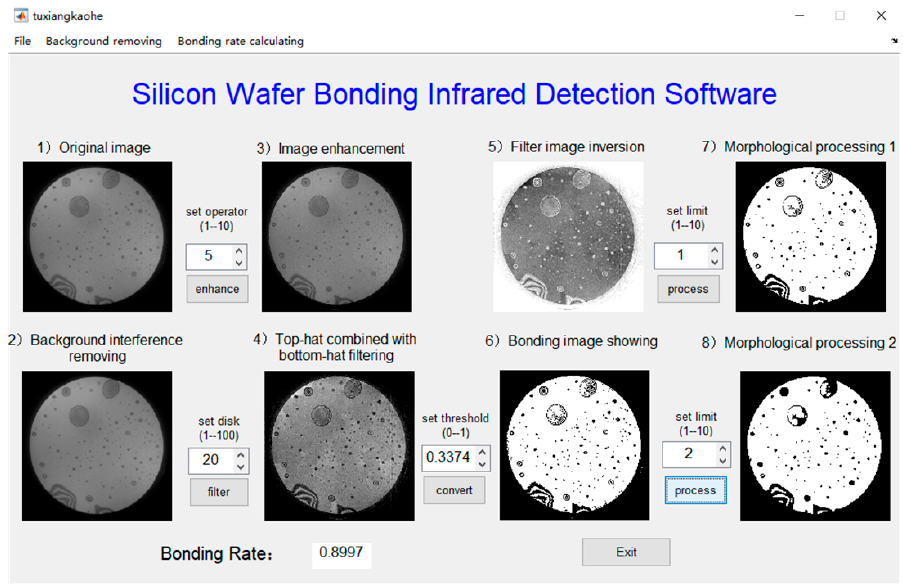
Figure 4. The running result of four-neighbor sharpening operator pattern.